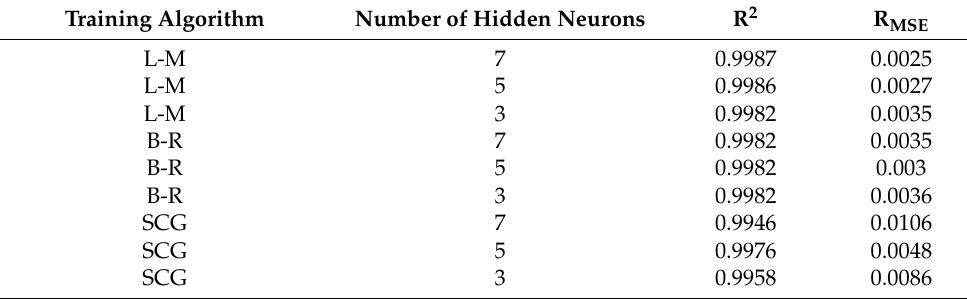
Table 5. Parameter results for SBS content model.